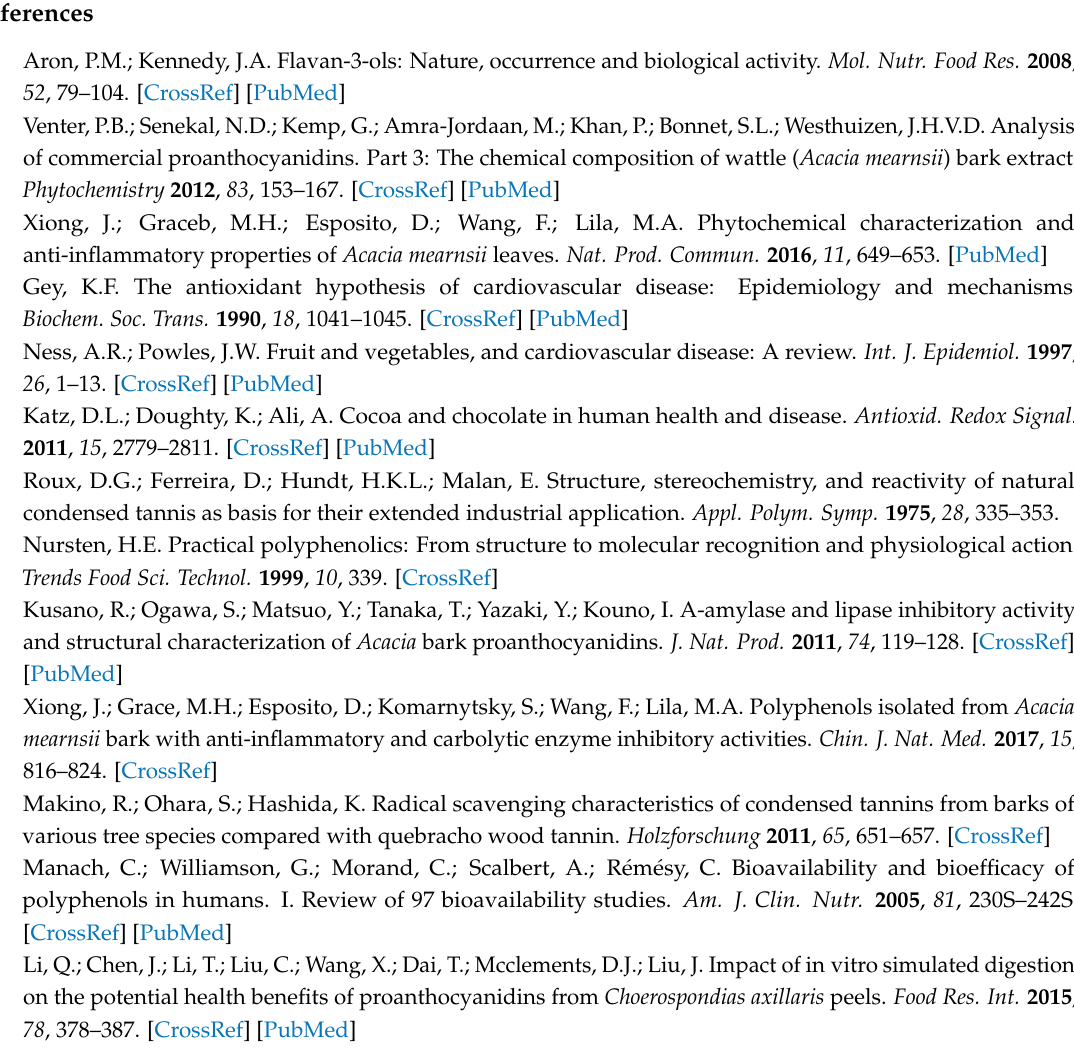
during the simulated gastric-intestinal digestion without enzymes. Figure S1: Product ion scans (MS and MS 2 ) of the m / z 289 molecular fragment in the IN sample. Figure S2: Product ion scans (MS and MS 2 ) of the m / z 305 molecular fragment in the IN sample. Figure S3: Product ion scans (MS and MS 2 ) of the m / z 561 molecular fragment in the IN sample. Figure S4: Product ion scans (MS and MS 2 ) of the m / z 577 molecular fragment in the IN sample. Figure S5: Product ion scans (MS and MS 2 ) of the m / z 593 molecular fragment in the IN sample. Figure S6: Product ion scans (MS and MS 2 ) of the m / z 833 molecular fragment in the IN sample. Figure S7: Product ion scans (MS and MS 2 ) of the m / z 849 molecular fragment in the IN sample. Figure S8: Product ion scans (MS and MS 2 ) of the m / z 865 molecular fragment in the IN sample. Figure S9. Product ion scans (MS and MS 2 ) of the m / z 881 molecular fragment in the IN